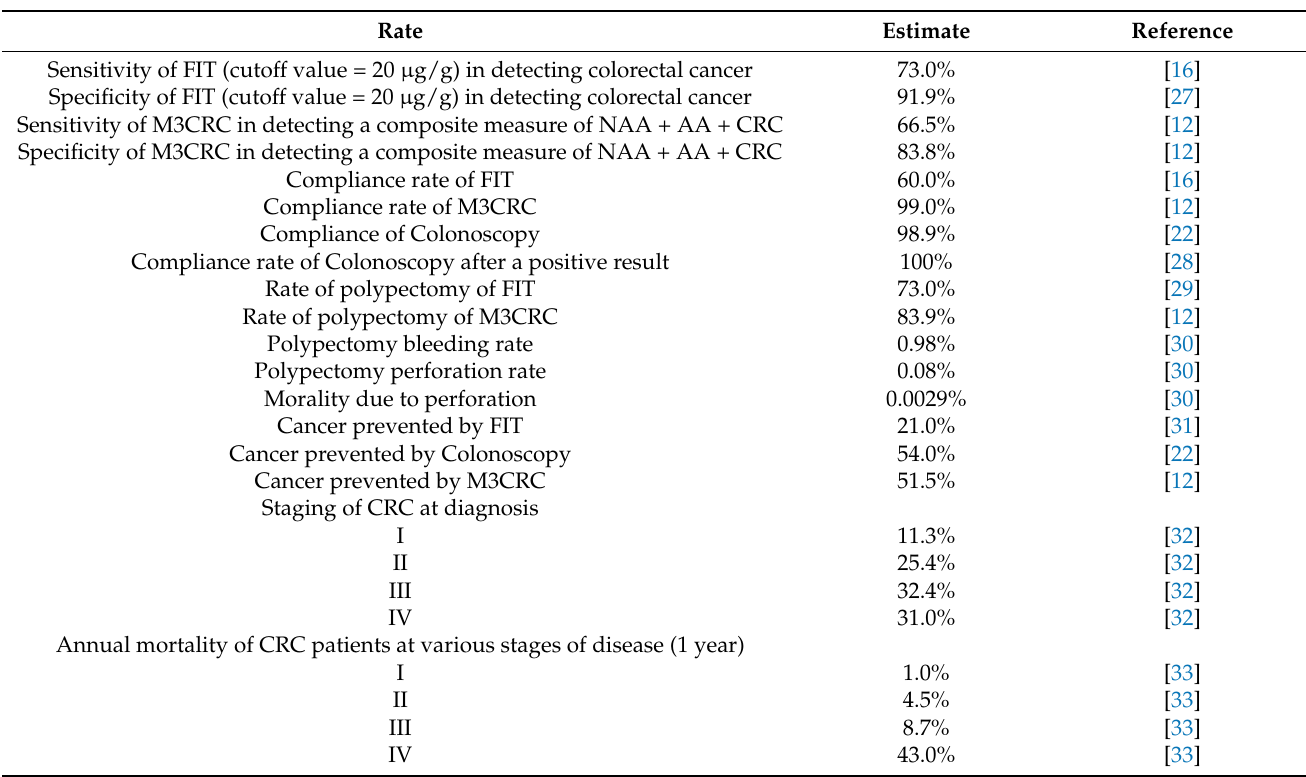
Table 1. Baseline estimates for the screening strategies. Rate